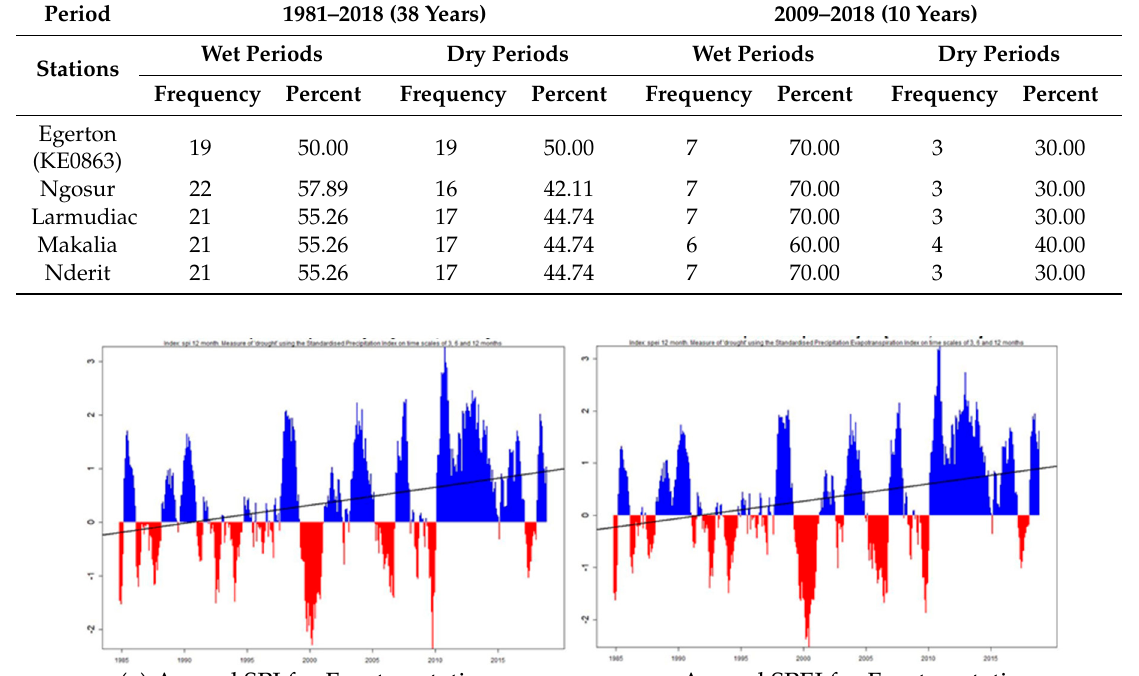
Figure 6. Comparison between CHIRPS and observed rainfall data on annual time